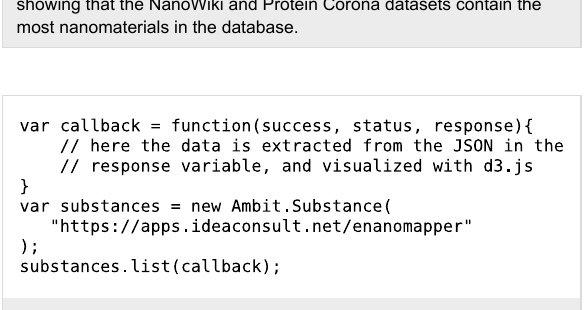
Figure 16: API call in ambit.js code.